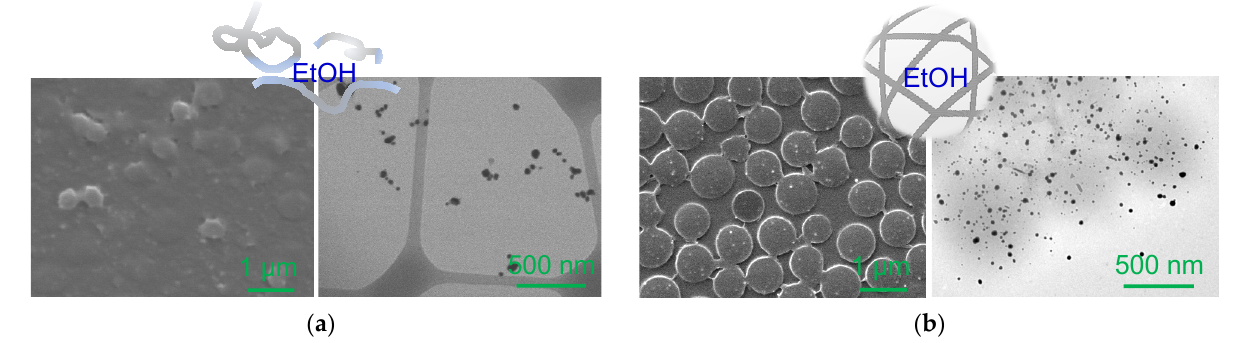
Figure 5. SEM and TEM images of composite particles prepared with ( a ) crosslinker-free and ( b ) crosslinked PNIPAM as well as their speculated structural features in EtOH.